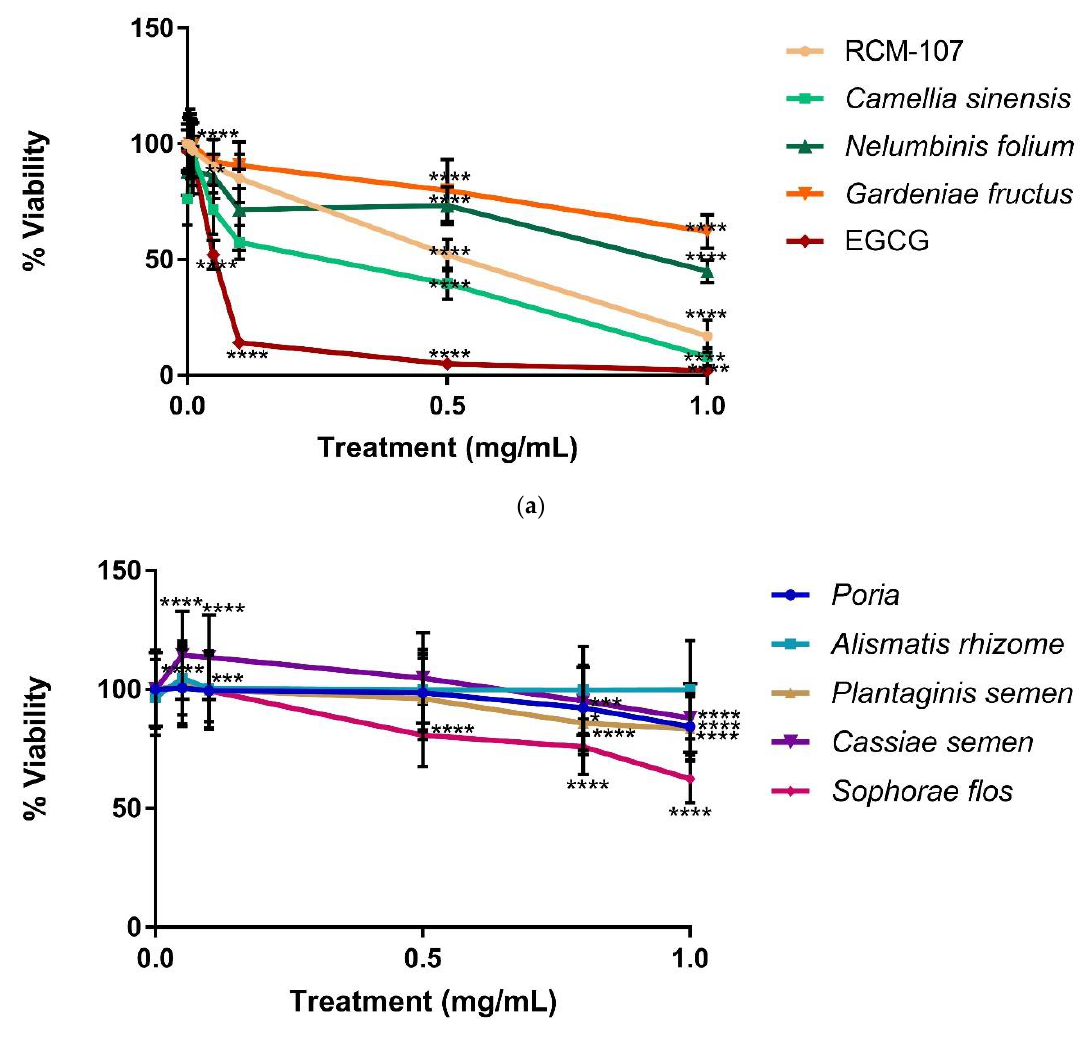
Figure 1. ( a ) Cell viability after 24 h of treatment of NCI-H716 cells with RCM-107, Camellia sinensis, Nelumbinis folium, Gardeniae fructus and epigallocatechin gallate (EGCG). Values are mean ± SD of three replicates per experiment **p < 0.01 and ****p < 0.0001 when compared with the corresponding untreated cells.; ( b ) Cell viability after 24 h of treatment of NCI-H716 cells with Poria, Alismatis rhizome, Plantaginis semen, Cassiae semen and Sophorae flos. Values are mean ± SD of three replicates per experiment *p < 0.05, *** p < 0.005 and ****p < 0.0001 when compared with the corresponding untreated cells.